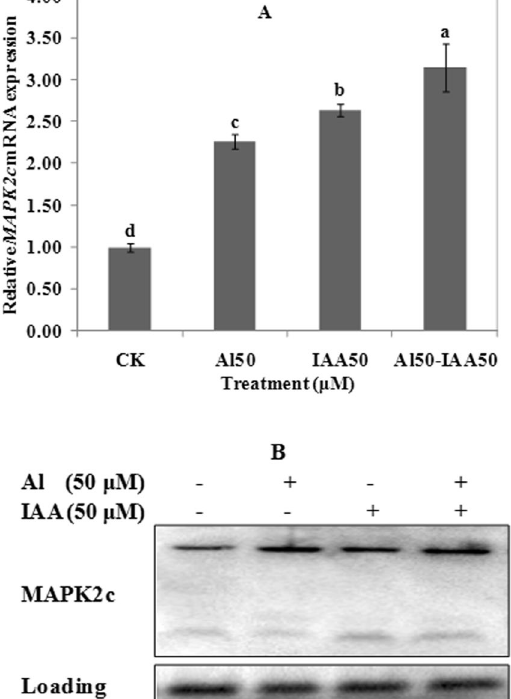
Figure 8. Expression of MAPK2c in wheat, RNA ( A ) and protein ( B ). Real time quantitative RT-PCR and western blot was used to assess MAPK2c gene and protein expression in root apexes (0–20 mm) of wheat lines ET8. Seedlings were exposed to 0.5 mM CaCl 2 solution (pH 4.5) containing other chemicals: 0 μ M AlCl 3 (CK), 50 μ M AlCl differences in the same figure mean significant difference at P <